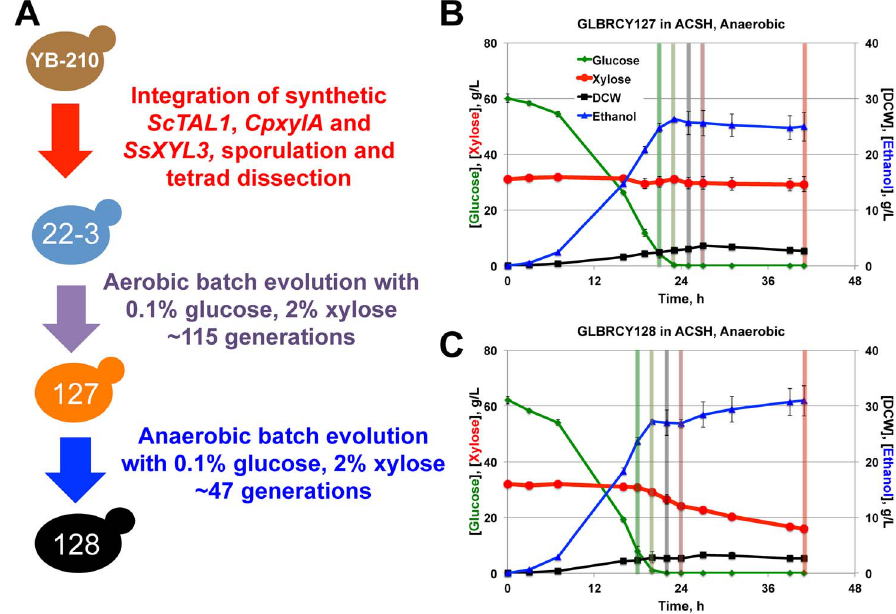
Figure 5. GLBRCY128 can anaerobically ferment xylose from ACSH. A diagram summarizing the engineering and evolution of the YB-210 strain into the evolved Y128 strain is provided in ( A ). Fermentation kinetic profiles of the Y127 ( B ) and Y128 ( C ) strains cultured in bioreactors containing ACSH and sparged with nitrogen from biological duplicates are shown. Average concentrations and standard deviations of indicated components were quantified from media samples at times from initial inoculation. Vertical colored bars indicate time points at which samples were taken for metabolomic analysis described in Fig. 7A–D. doi:10.1371/journal.pone.0107499.g005 PLOS ONE |